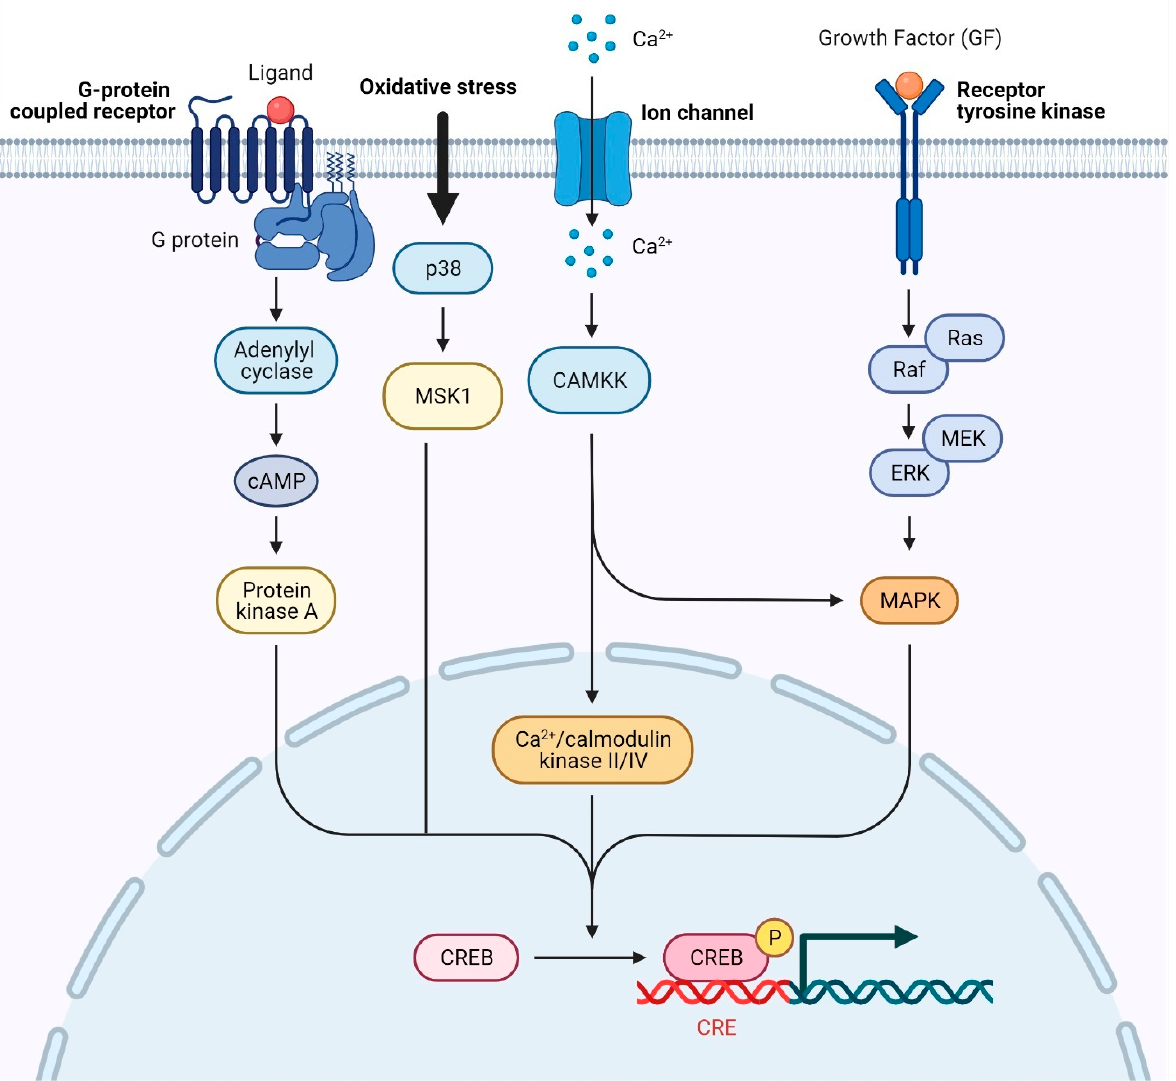
Figure 3. CREB expression is regulated via signal transduction pathways Cellular growth factors (GFs) may activate PI3K/AKT or Ras/MEK/ERK pathways when they connect to the membrane- bound receptor. Activation of calcium-dependent kinases increases as Ca 2+ inflow increases. PKA is turned on when hormone receptors and G-protein-coupled receptors activate adenylate cyclase. All signal transduction pathways may phosphorylate CREB at different serine sites. PKA, protein ki- nase A; cAMP response element-binding protein, CREB.